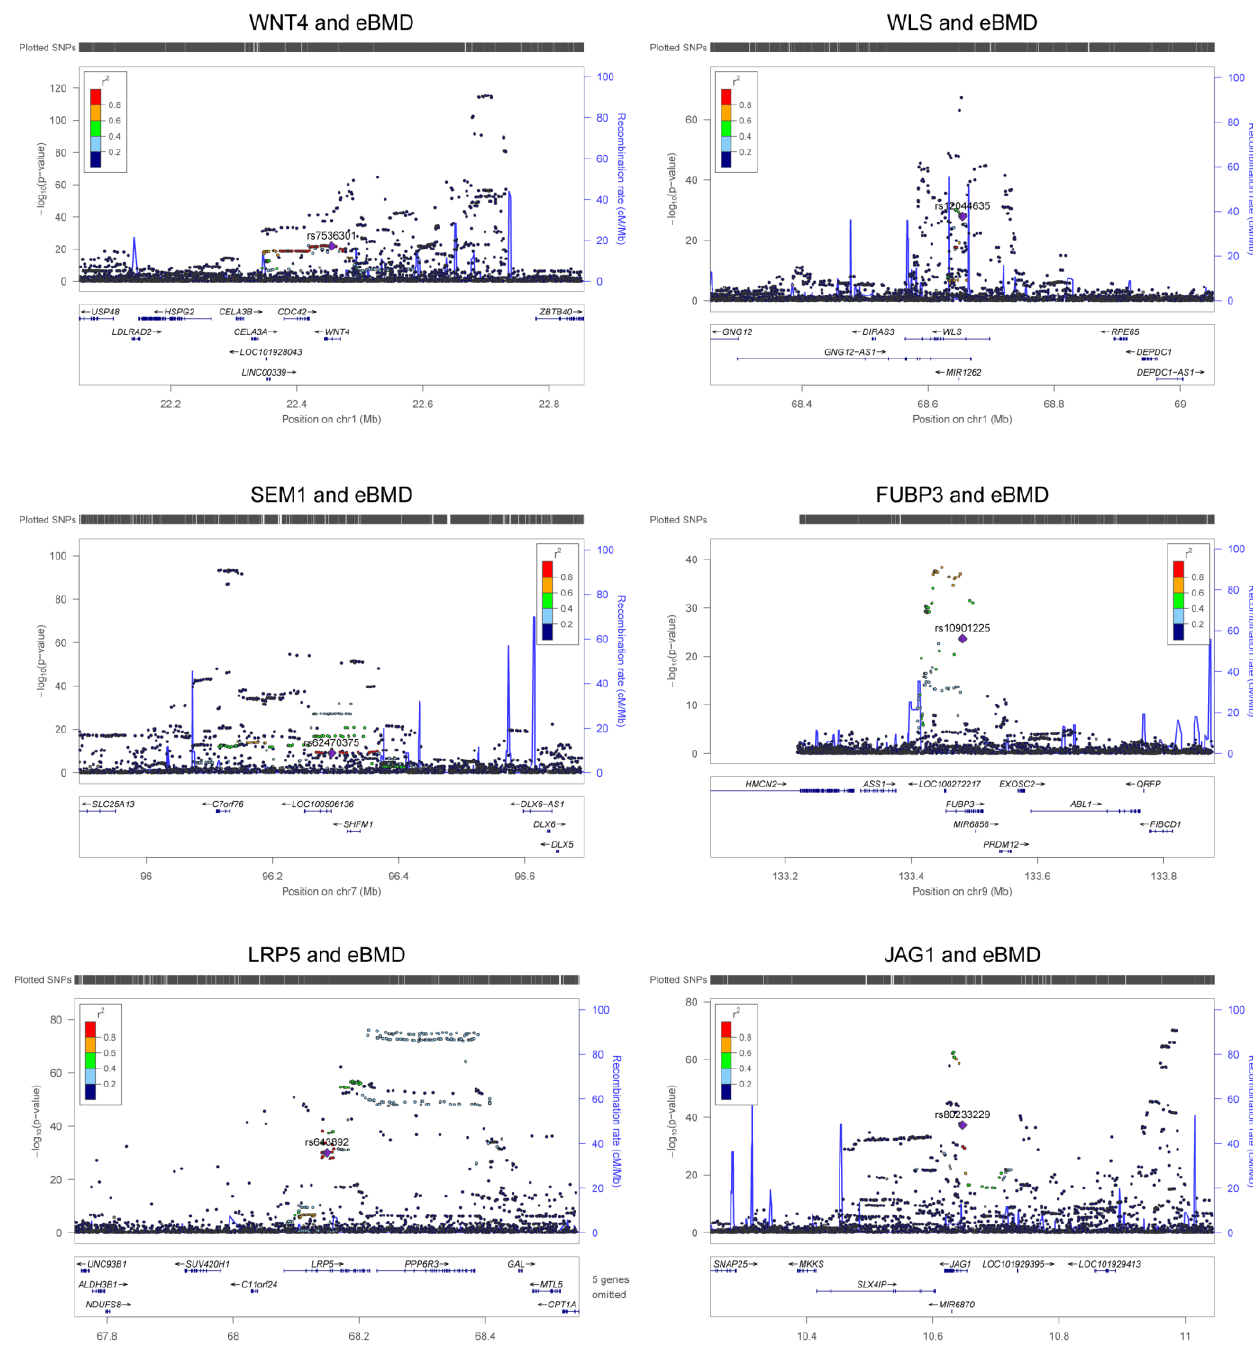
Figure 3. Association signals of m 6 A-SNPs with eBMD. The six regional association plots show the associations between m 6 A-SNPs in key OP susceptibility genes and eBMD. The m 6 A-SNPs in each gene locus are annotated in the plot.